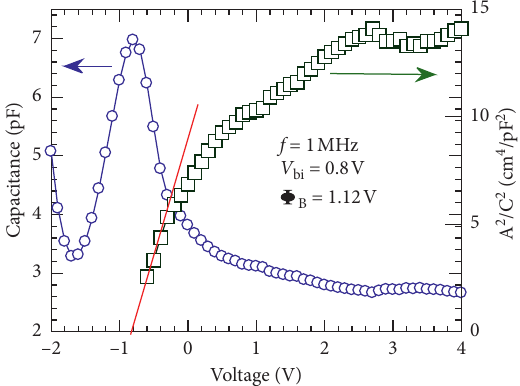
Figure 5: C - V and A /C 2 vs. V plot at the frequency of